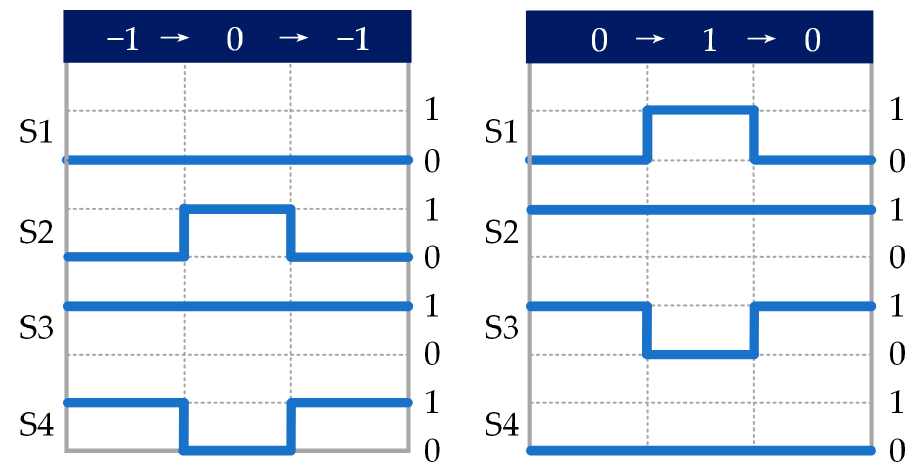
Figure 7. The principle of switching vector.